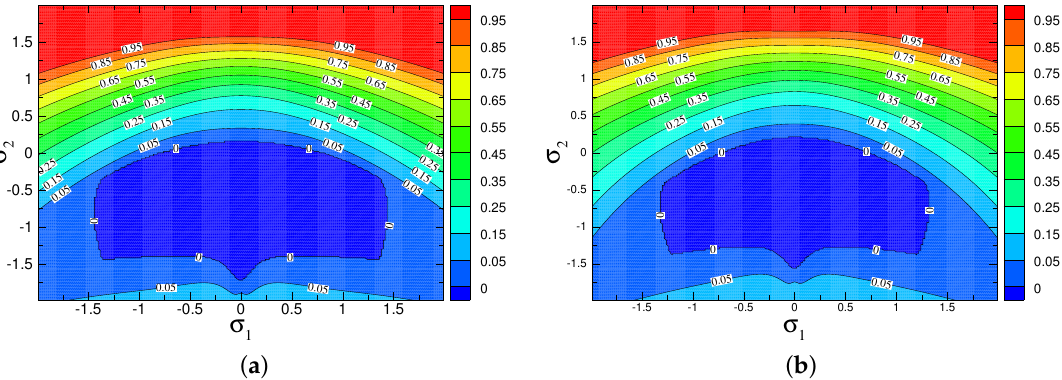
Figure 11. Contours of maximum growth rate ω i , max for Re = 1000: ( a ) symmetric slip ( β 1 = β 2 = 0); and ( b ) non-symmetric slip ( β 1 = β 2 (cid:54) = 0).